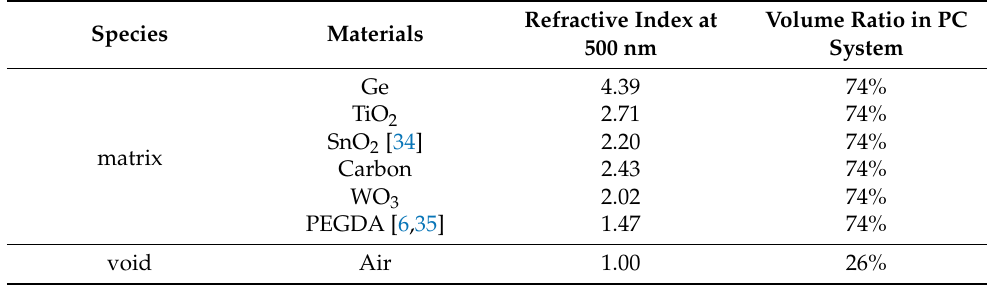
Table 1. The parameters of the matrix materials.